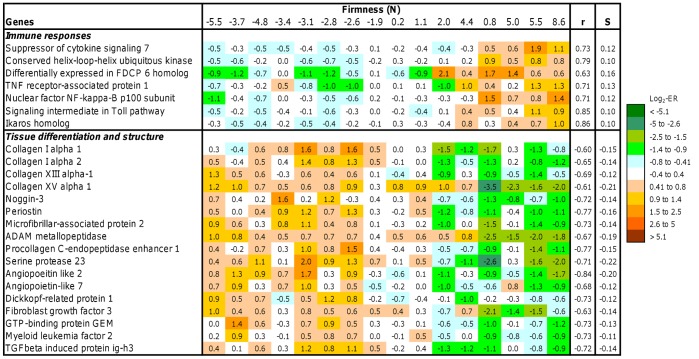
Expression of genes associated with immune response, tissue structure and remodeling in skeletal muscle of salmon with varying firmness (n = 16 fish).Data are log2-ER and are highlighted with a color key. r =  Pearson correlation coefficient, S =  coefficient of linear regression (S – slope).